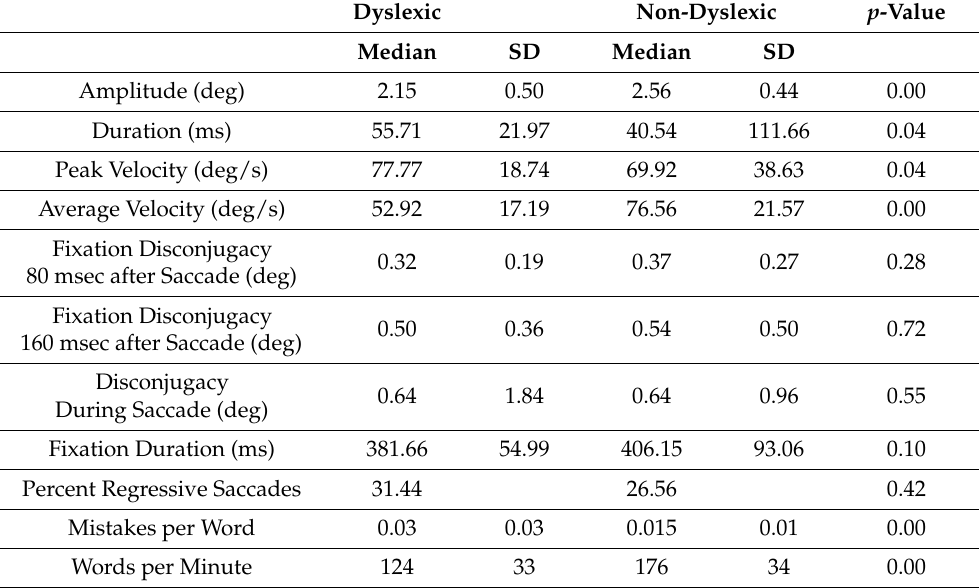
Table 2. Reading 35 Kilos D’Espoir .